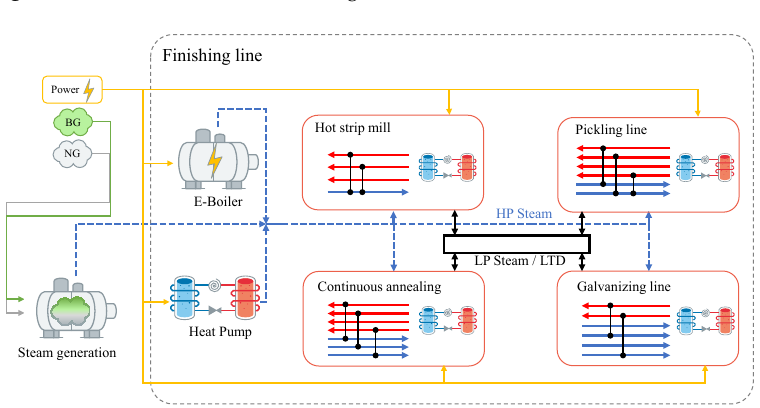
Figure 6. Previous work contributing to the model used in this work [14,25–27]